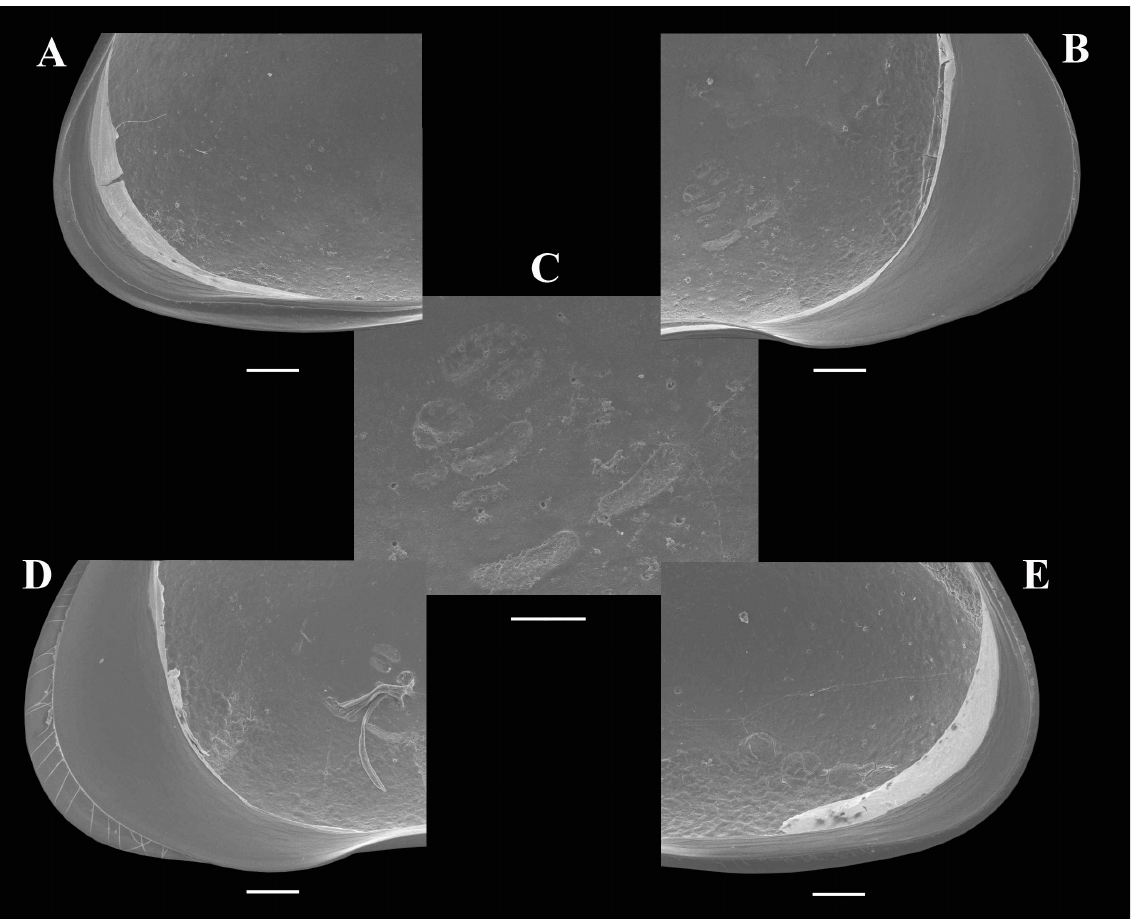
Fig. 3. Martensina thailandica gen. et sp. nov., allotype, ♀ (MSU-ZOC.318). A . LV, internal view, posterior part. B . LV, internal view, anterior part. C . LV, internal view, muscle scars. D . RV, internal view, anterior part. E . RV, internal view, posterior part. Scale bars: A–B, D–E = 100 μm; C = 50